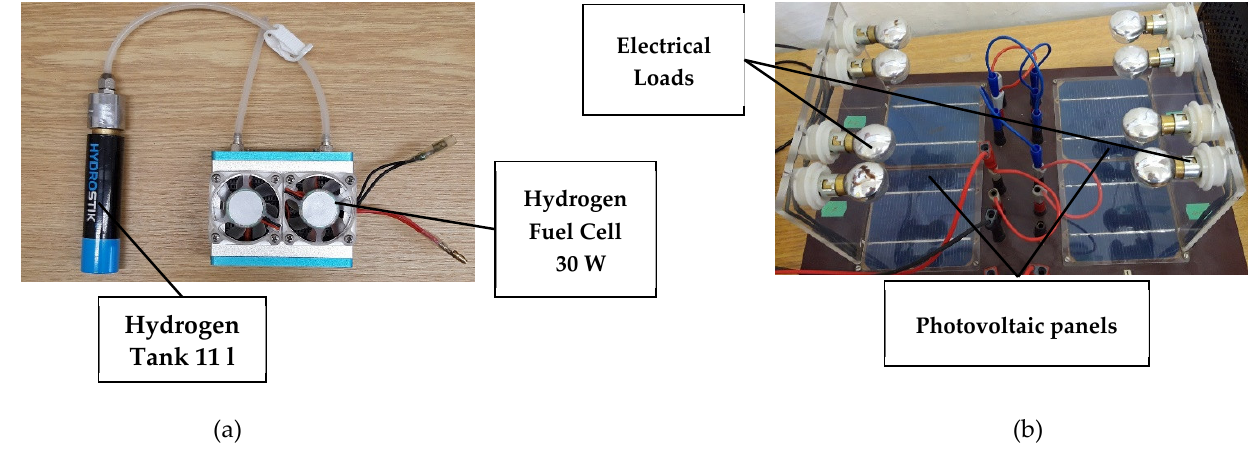
Figure 10. ( a ) Fuel cell; ( b ) solar power.